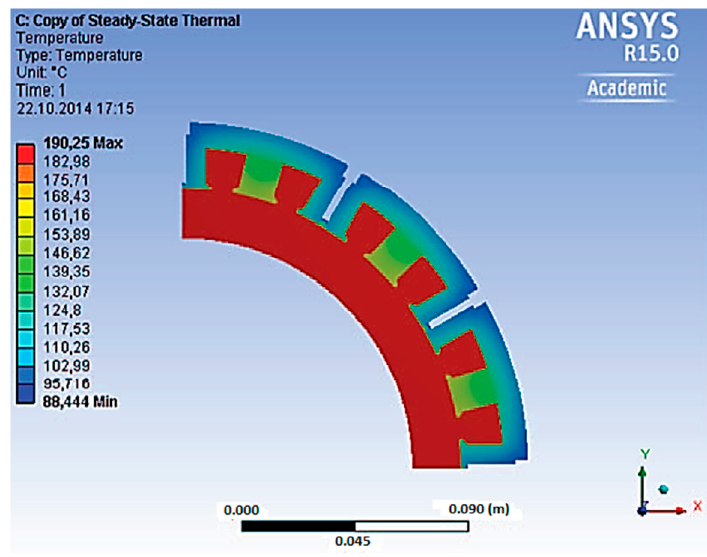
Figure 13. Temperature profile in flux barrier cooling of PMSM [60].